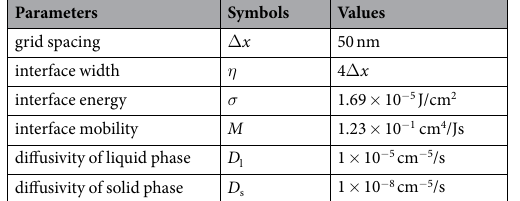
Table 2. List of the numerical and materials parameters used in the present phase-field simulations.